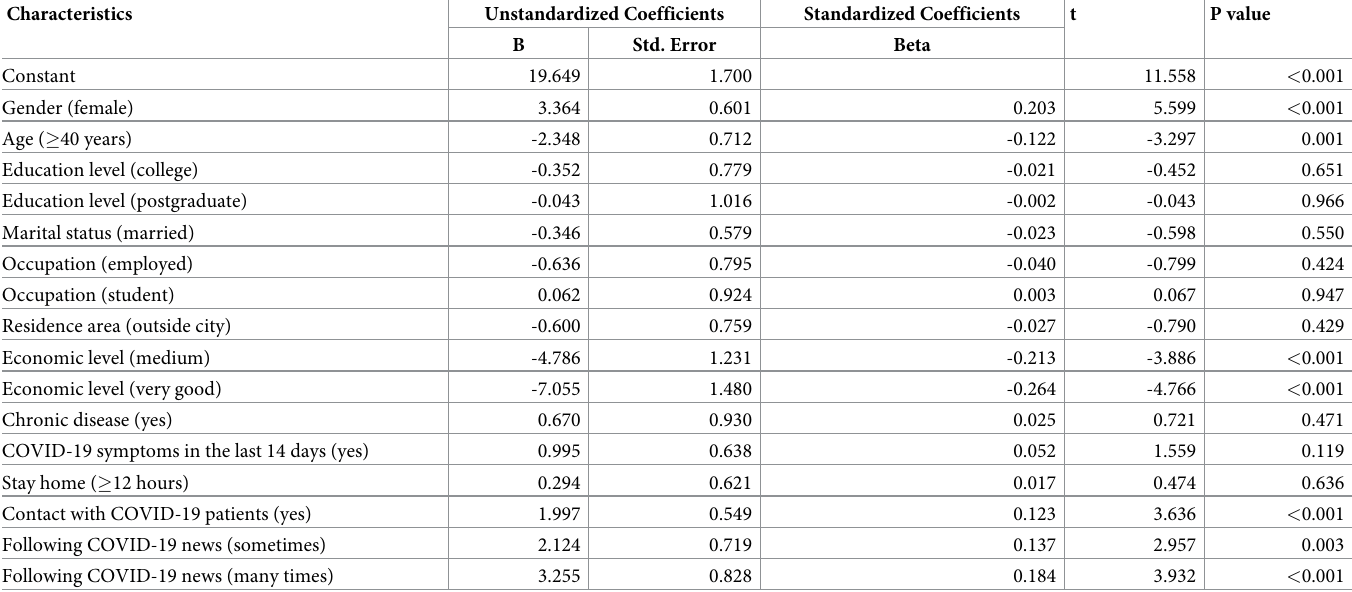
Table 4. Analysis of sociodemographic and clinical characteristics of the respondents on stress level by regression analysis.